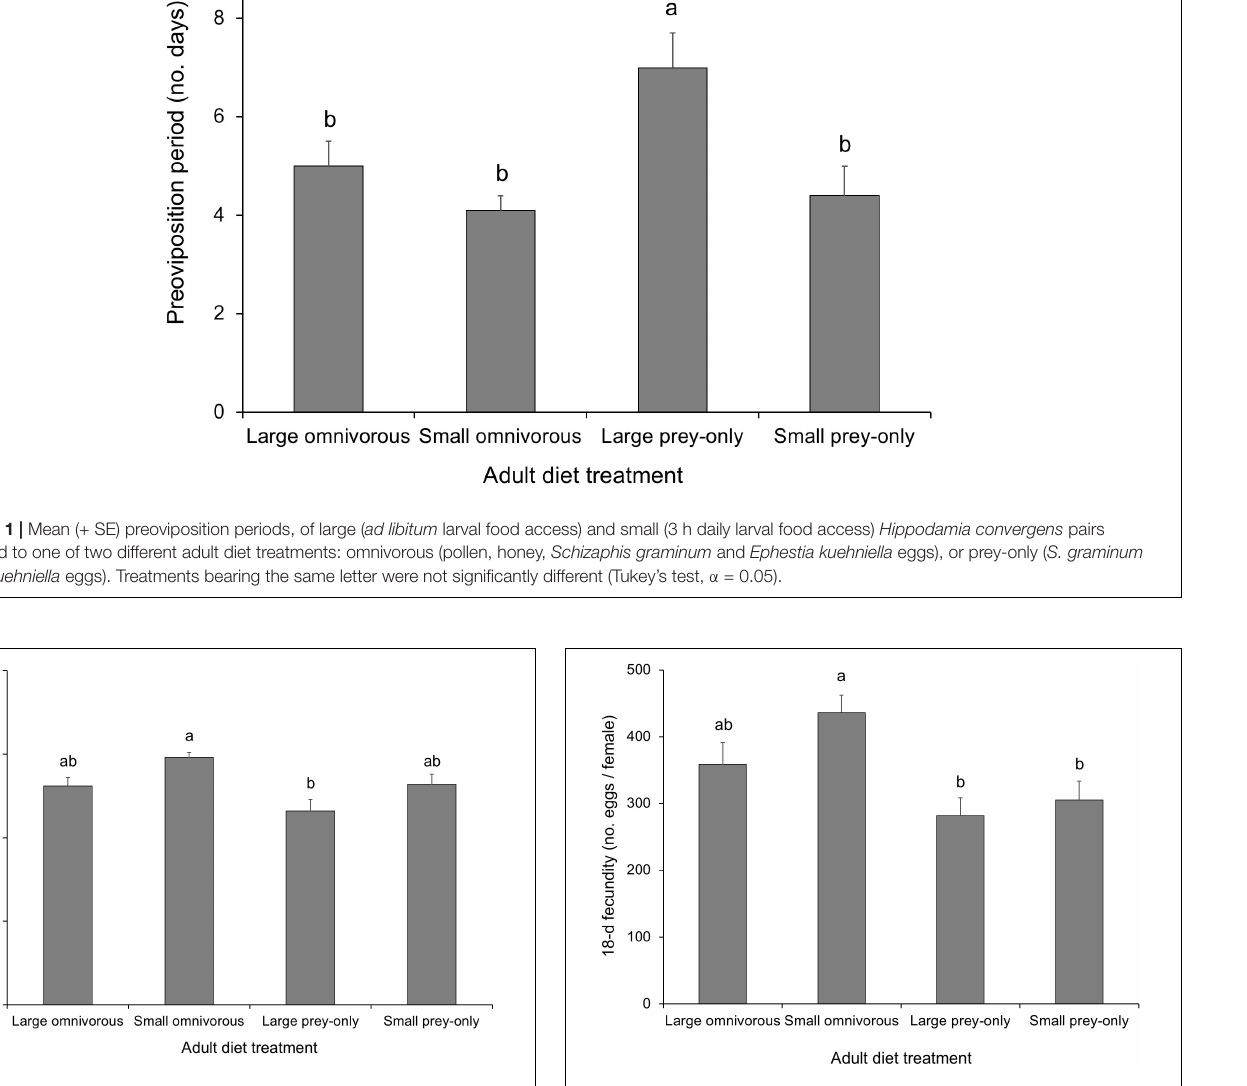
FIGURE 3 | Mean (+ SE) 18-days fecundities of large ( ad libitum larval food access) and small (3 h daily larval food access) Hippodamia convergens pairs subjected to one of two different adult diet treatments: omnivorous (pollen, honey, Schizaphis graminum, and Ephestia kuehniella eggs), or prey-only ( S. graminum and E. kuehniella eggs). Treatments bearing the same letter were not significantly different (Tukey’s test, α =